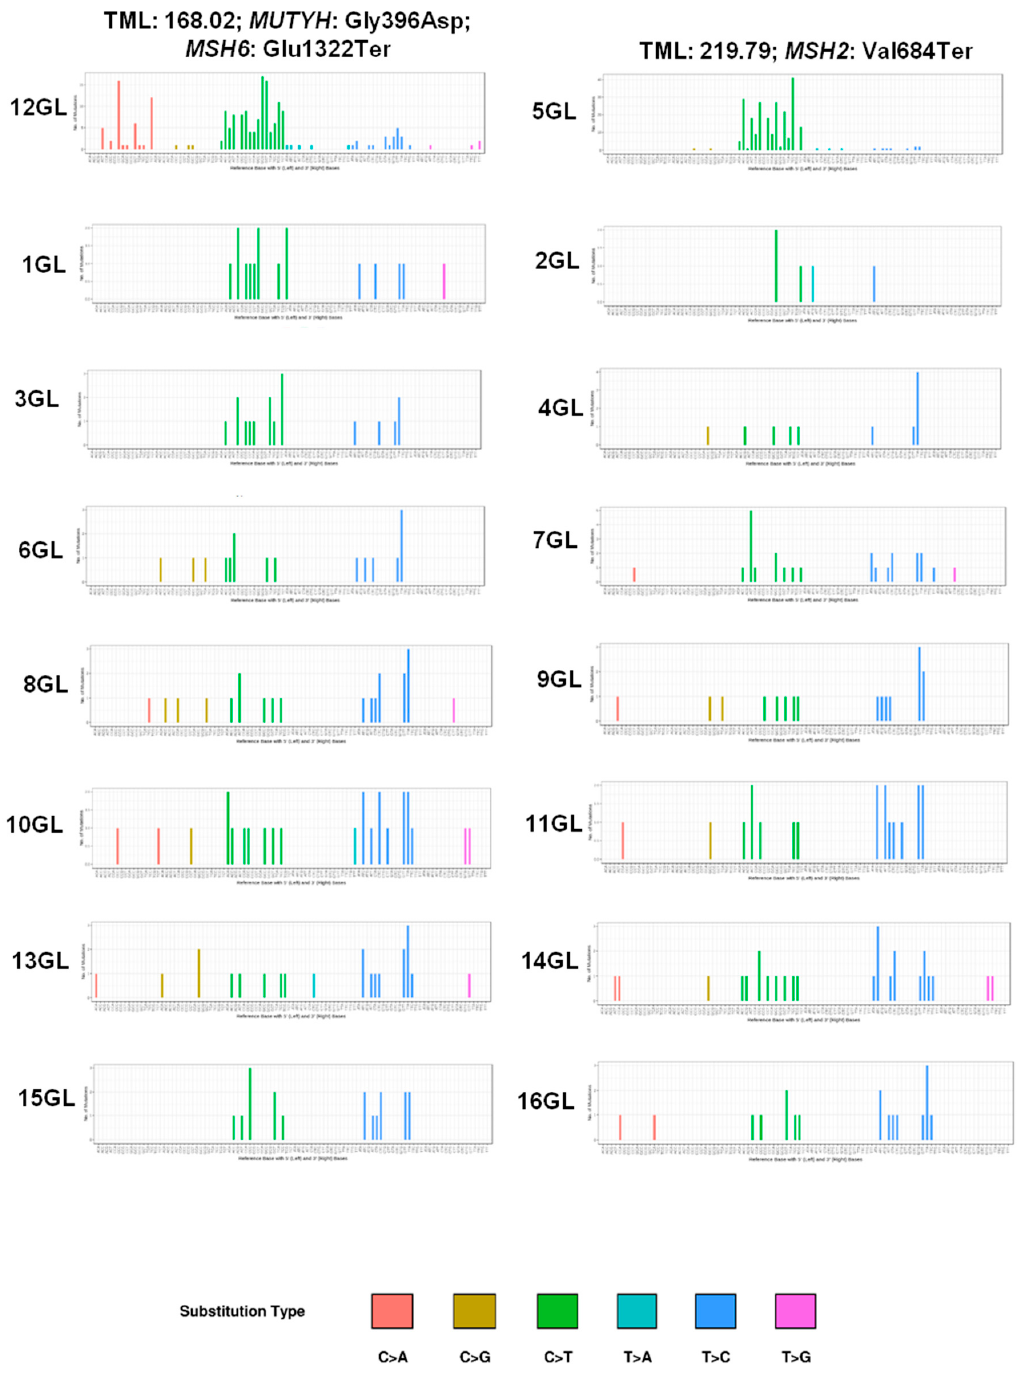
Figure 4. Mutational signatures of 16 IDH -wt glioblastomas. The signatures of somatic mutations (mutational spectrum) of individual tumours were obtained considering six major mutation classes: C > T; C > A; C > G; T > A; T > C; T > G. On top are the two ultra-mutated samples with indications of tumour mutational load (TML) and the peculiar molecular alterations. The mutational signature of case 12 GL shows a predominance of C > T over T > C transitions, and four peaks of C > A transversions in the trinucleotide contexts CCT, TCT, GCT, and ACT; this latter mutational pattern corresponds to signature SBS14 in the Catalogue Of Somatic Mutations In Cancer (COSMIC) version 3, and is associated to tumours with concurrent impairment of DNA mismatch repair and POLE proofreading functions (https: // cancer.sanger.ac.uk / cosmic / signatures / SBS / ) [25]. On the horizontal axis, the reference base with 5 (cid:48) (left) and 3 (cid:48) (right) bases are shown. On the vertical axis, the number of mutations is